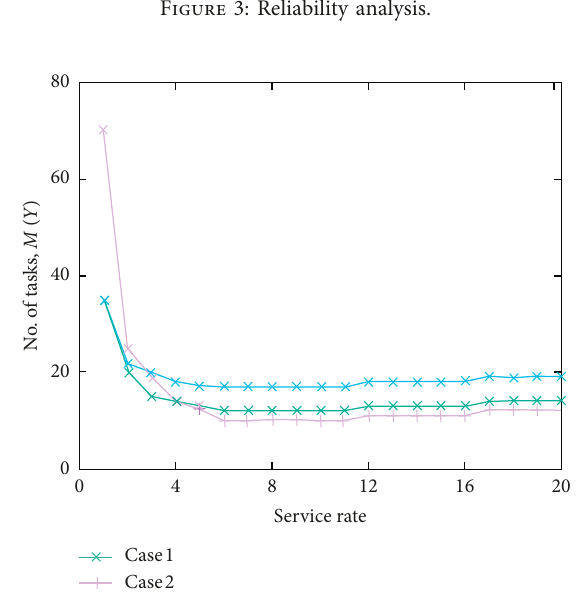
Figure 3: Reliability analysis.